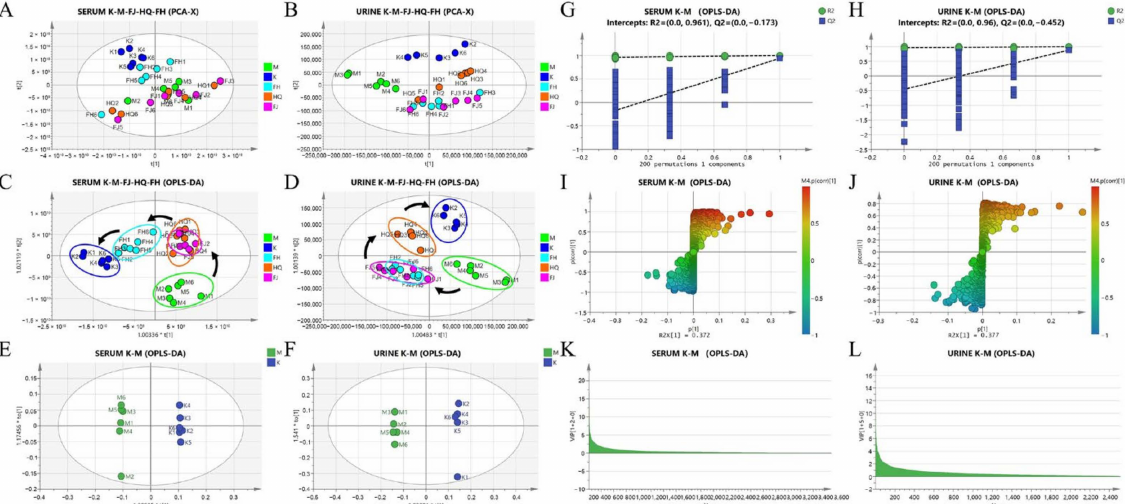
Figure 6. Metabolic profile analysis of serum and urine samples in each group. Note: PCA score plots for serum ( A ) and urine ( B ) samples in each group; OPLS-DA score plots for serum ( C ) and urine ( D ) samples in each group; OPLS-DA score plots of serum ( E ) and urine ( F ) samples of K group and M group; permutation plots of serum ( G ) and urine ( H ) samples of K group and M group; S-plot of serum ( I ) and urine ( J ) samples of K group and M group; VIP plots of serum ( K ) and urine ( L ) samples from K and M